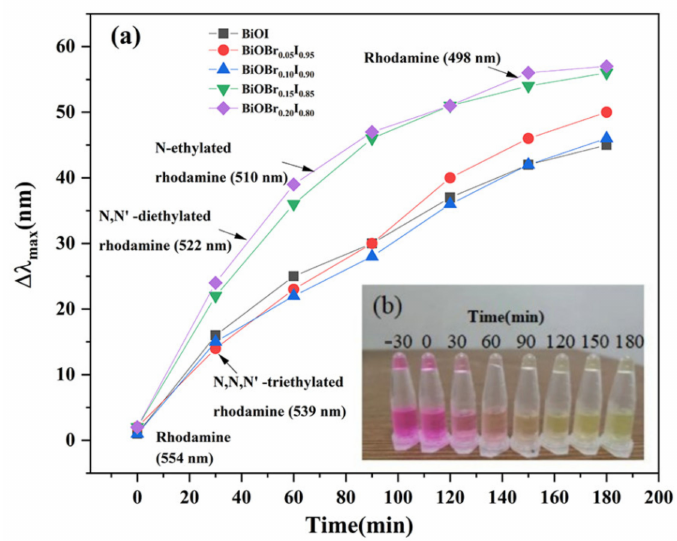
Figure 9. Blue shift in degradation of RhB: ( a ) the “blue shift” of the maximum absorption wavelength of the solution varies with the illumination time; ( b ) the color change of solution during degradation of BiOBr 0.15 I 0.85